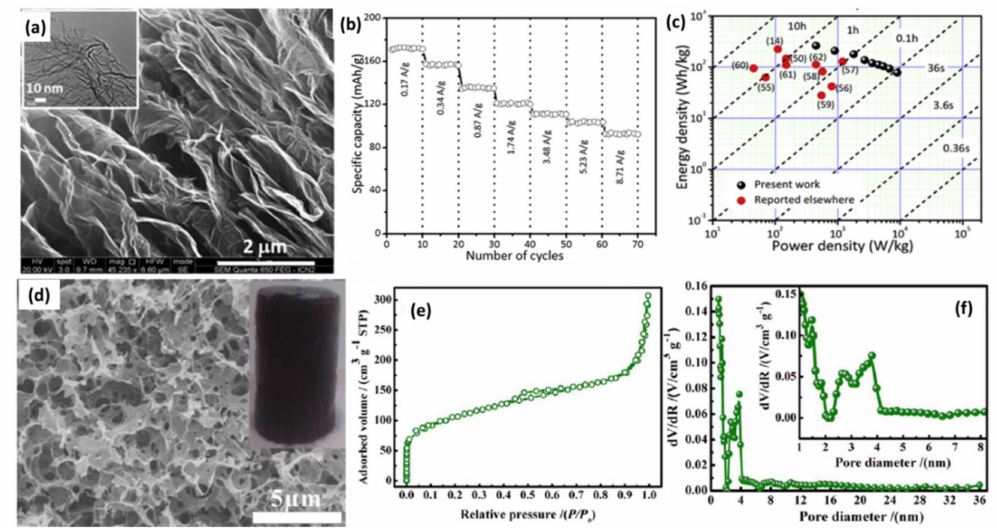
Figure 3. ( a ) FESEM of PRGO (inset shows TEM image); ( b ) Rate capability of PRGO; ( c ) Ragone plot for N-CNPipes//PRGO LIC and other devices. (Reprinted with permission from Ref. [89]. Copyright 2018 Elsevier.) ( d ) SEM image (The inset is the corresponding picture of the PGM), ( e ) N 2 sorption isotherm, and ( f ) the pore size distribution curves of PGM. (Reprinted with permission from Ref. [91]. Copyright 2015 Elsevier.).